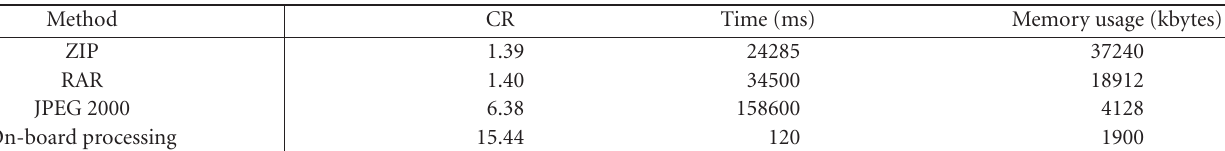
Table 3: Comparison of compression performances on NGC 1808 raw IR images (1032 frames) between JPEG 2000, ZIP, RAR, and the proposed approach.